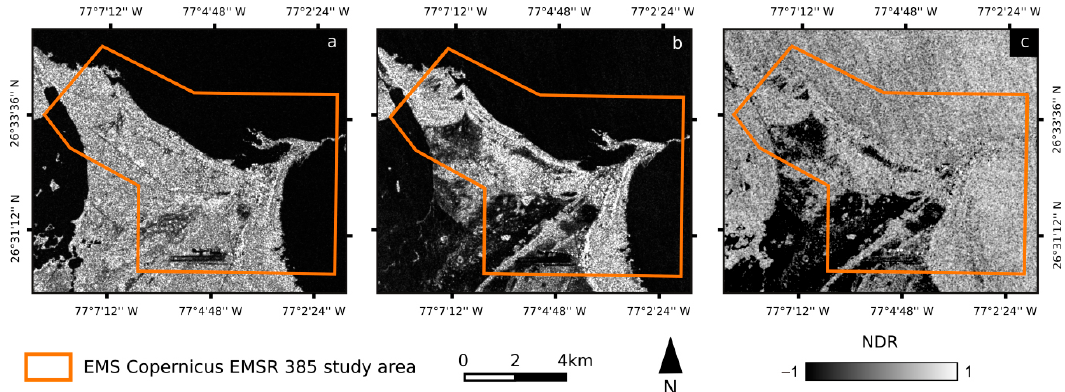
Figure 8. SAR and NDR images for Beira area. ( a ) SAR image from 18 February 2019; ( b ) SAR image from 20 March 2019; ( c ) NDR.